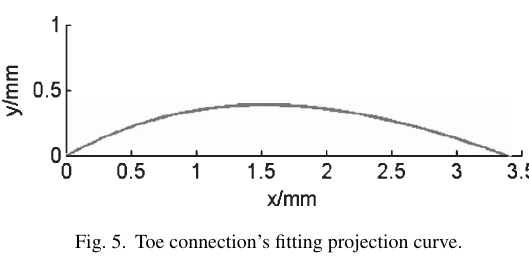
Fig. 5. Toe connection’s fitting projection curve.